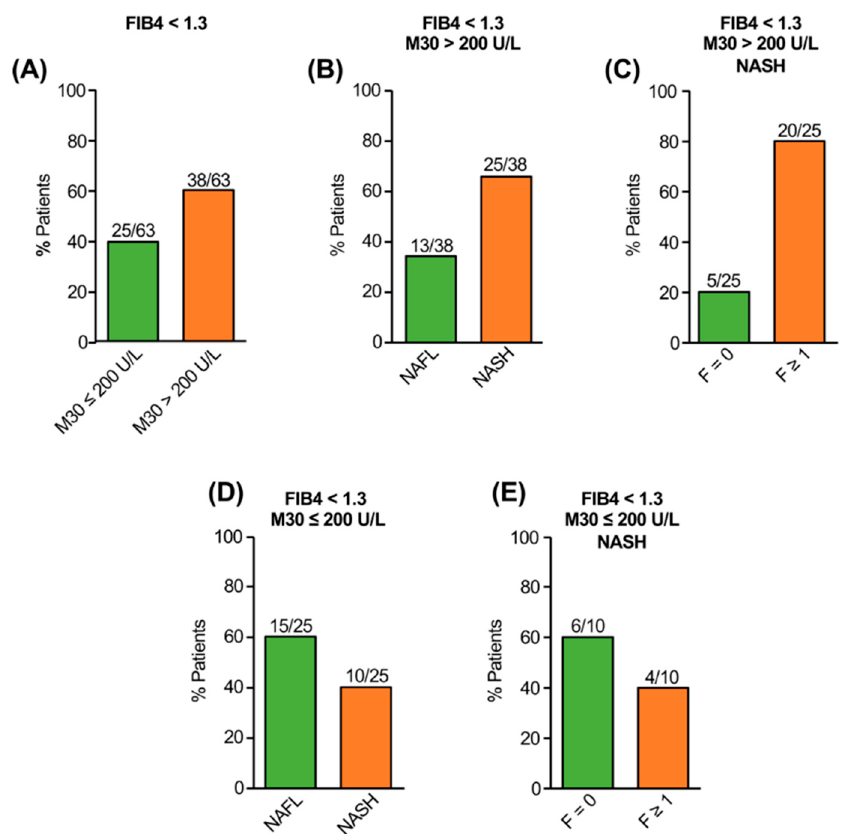
Figure 2. Validation of the M30 marker for the detection of NASH and fibrosis in NAFLD patients with low FIB-4. In the majority of NAFLD patients with FIB-4 < 1.3 elevated M30 levels (>200 U/L) could be detected ( A ), and most of them revealed NASH ( B ). Most patients with NASH and elevated M30 showed histological fibrosis despite FIB-4 < 1.3 ( C ). Vice versa, most NAFLD patients with FIB-4 < 1.3 and non-elevated M30 levels revealed NAFL ( D ). Most patients with NASH despite low FIB-4 and non-elevated M30 levels did not show histological fibrosis ( E ).